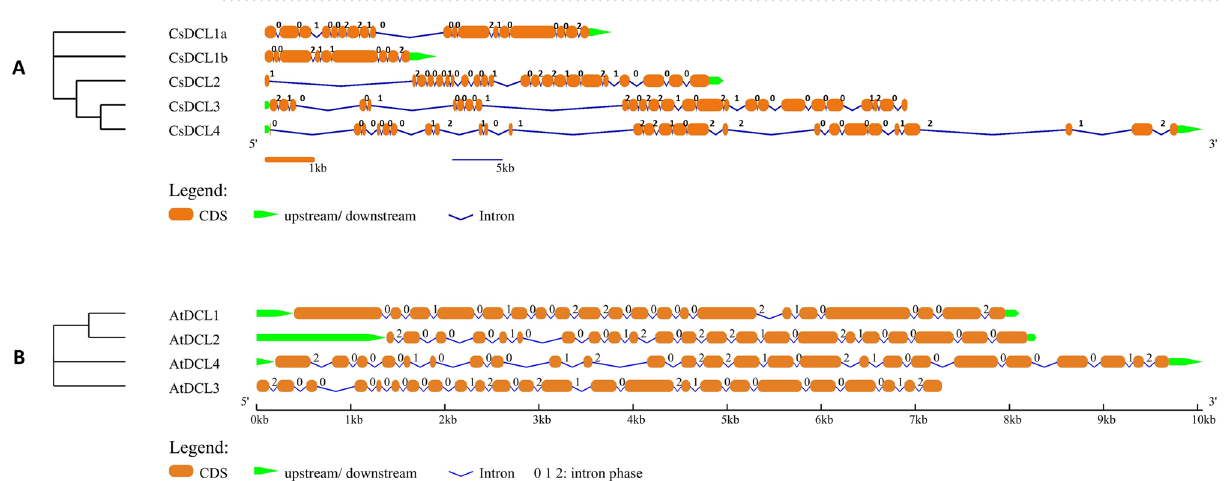
Figure 3. Gene structures showing the organization of exons and introns, and associated intron phases [0, 1 and 2] of ( A ) CsDCL and ( B ) AtDCL genes. The NJ phylogenetic tree of CDS is shown on the left side of the